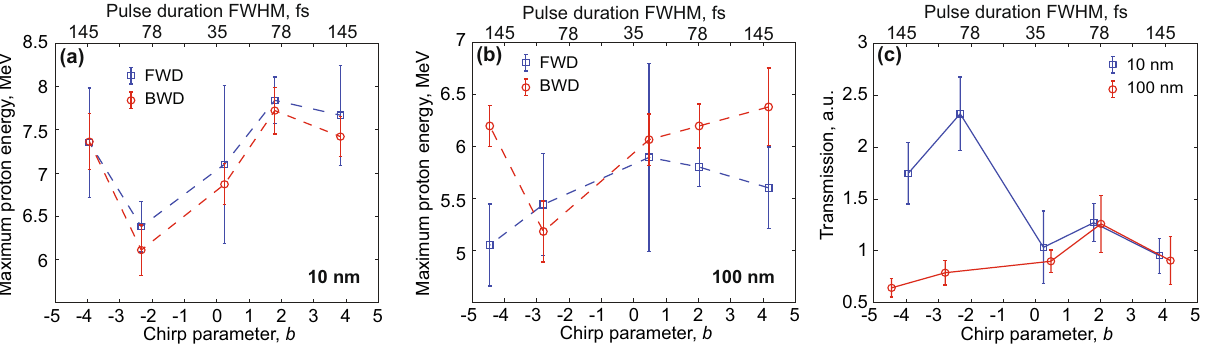
Figure 2. ( a , b ) Proton cut-off energies in forward (FWD) and backward (BWD) directions obtained from 10 nm- ( a ) and 100 nm-thick ( b ) carbon foils. ( c ) Transmitted laser light measured by the Spectralon, for both target thicknesses. In all panels, error bars represent the mean standard error calculated on the average